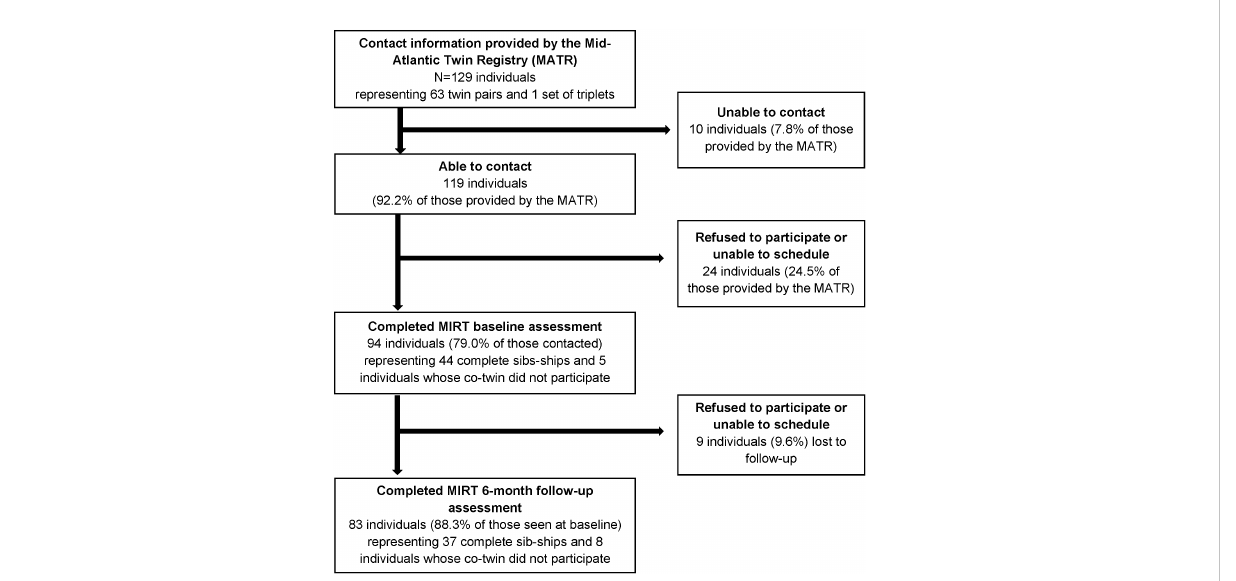
FIGURE 1 Flowchart of participant recruitment and retention in the Mood and Immune Regulation in Twins (MIRT) Study. Eligible and potentially interested twin pairs were fi rst identi fi ed and screened by the MATR, which then provided their contact information to the MIRT Study team for recruitment. Sib-ships include twin pairs and one set of triplets. All participants believed themselves to be monozygotic at the time of study enrollment. Genetic testing was conducted as part of the baseline assessment to con fi rm zygosity, which determined that 42 of the 44 twin pairs and the sole set of triplets were indeed genetically identical. Genetic testing was not conducted on those individuals whose co-twin did not participate in the study, as DNA from both members is necessary to determine